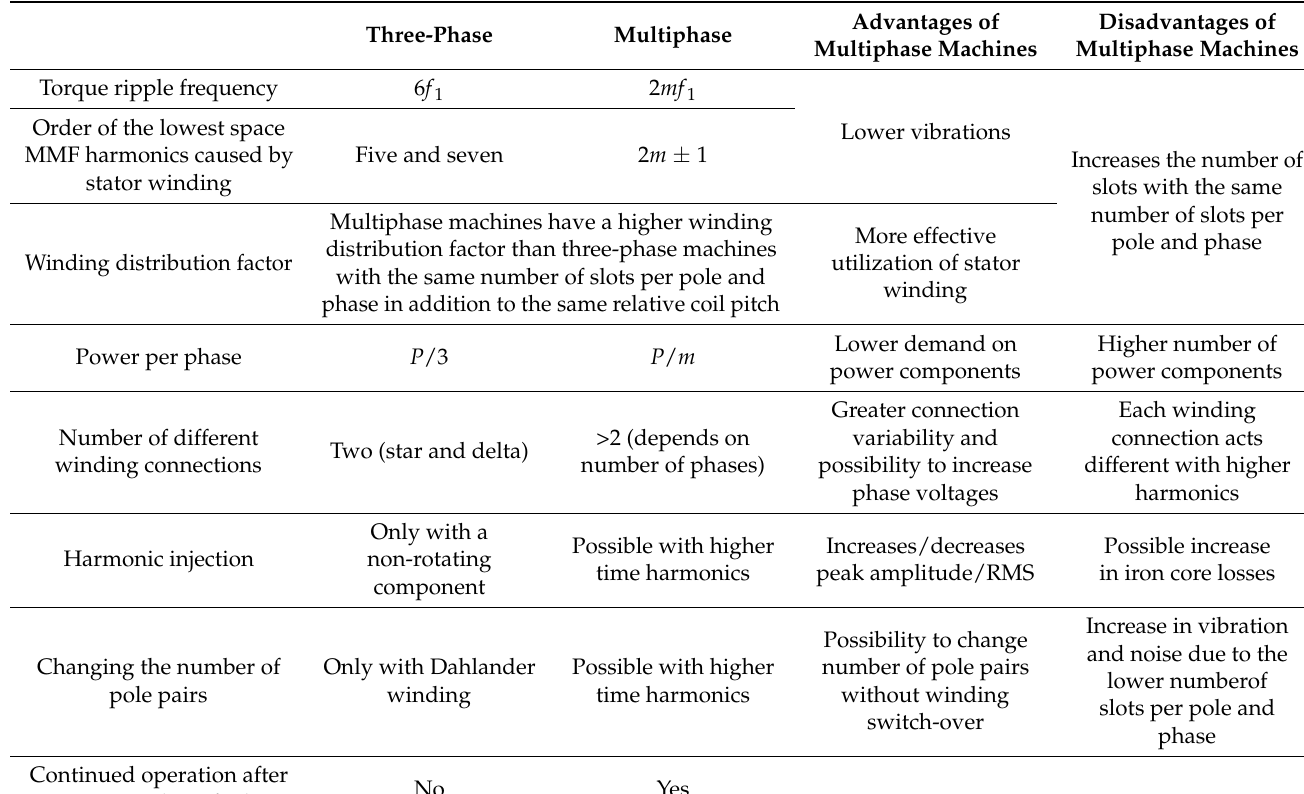
Figure 1. Evolution of published papers dealing with multiphase machines (inspired by [5]). Table 1. Comparison of multiphase and three-phase electric